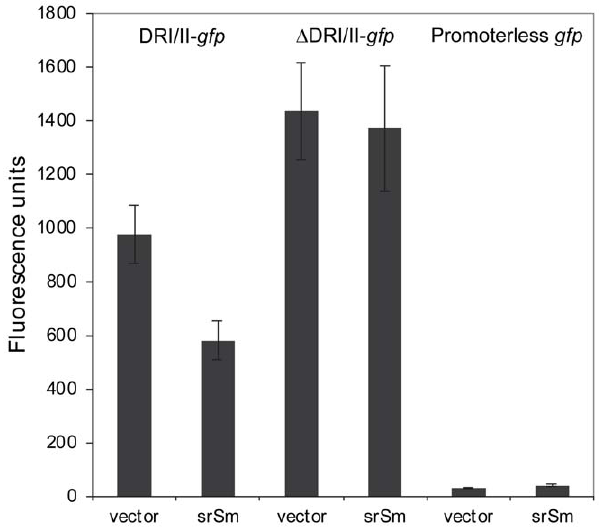
Figure 5. Characterization of the Fst-Sm/srSm TA system in E. coli . Cells of LMG194 containing pSK1 (Fst-Sm), pSK2 (Fst-Sm/srSm), and pSK8 (NT-Fst) were grown to mid-log phase, at which time arabinose (induced) and glucose (uninduced control) were added. After induction, appropriate dilutions were plated on LB agar for determination of the number of CFU per ml. The curves presented are the averages and standard deviations of results from three independent cultures.